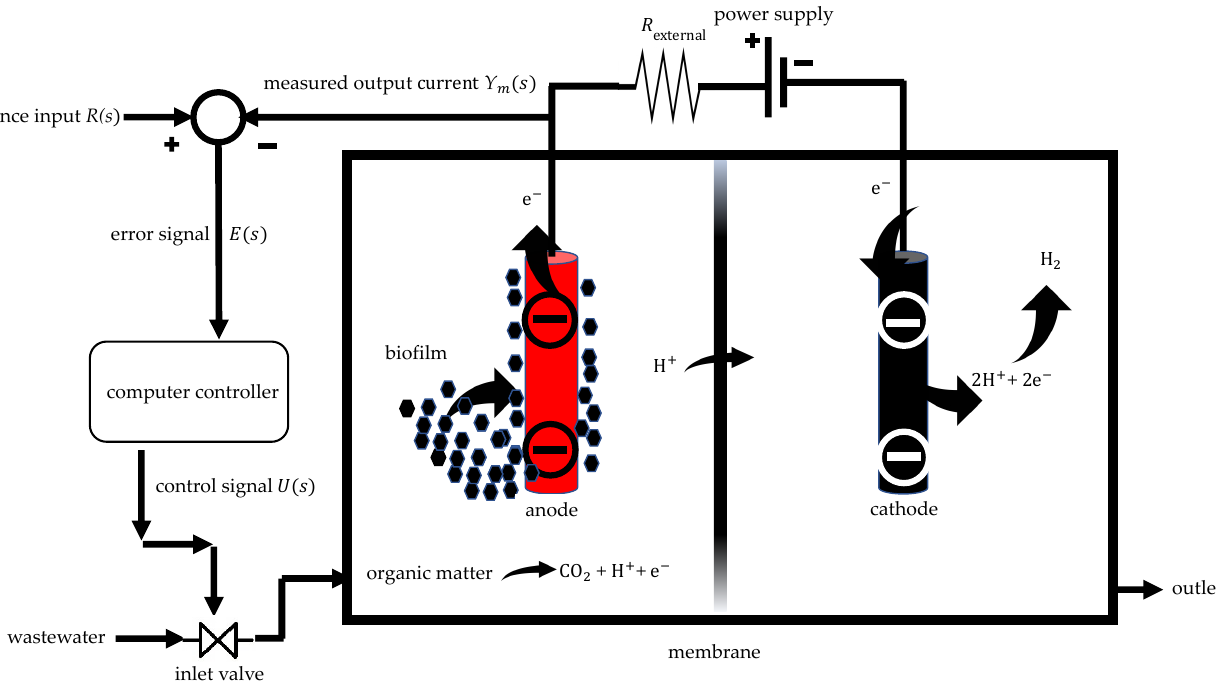
Figure 1. Diagram of a continuous MEC